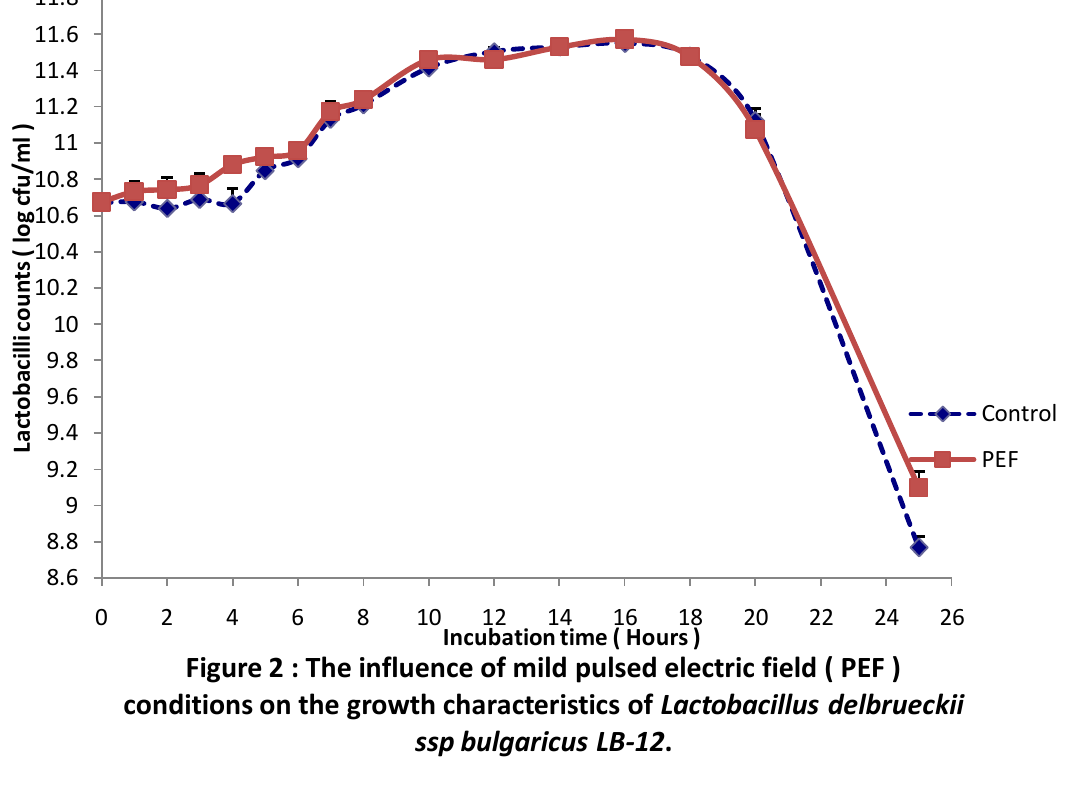
Figure 2 : The influence of mild pulsed electric field ( PEF ) conditions on the growth characteristics of Lactobacillus delbrueckii ssp bulgaricus LB-12 Table 3: Mean square (MS) and Pr > F of mild PEF treatment, hour, and their interaction for growth, bile tolerance and protease activity of Lactobacillus delbrueckii ssp. bulgaricus LB-12.